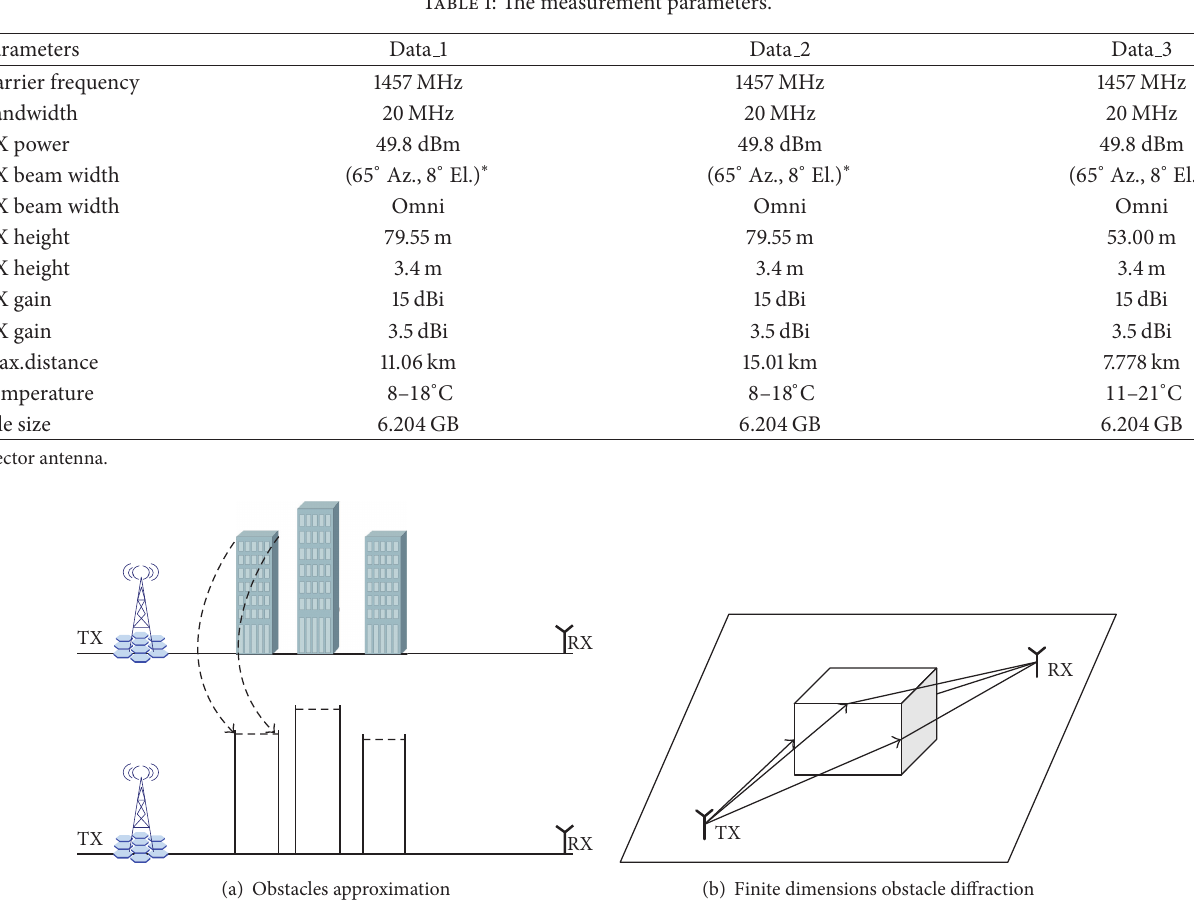
Table 1: The measurement parameters.